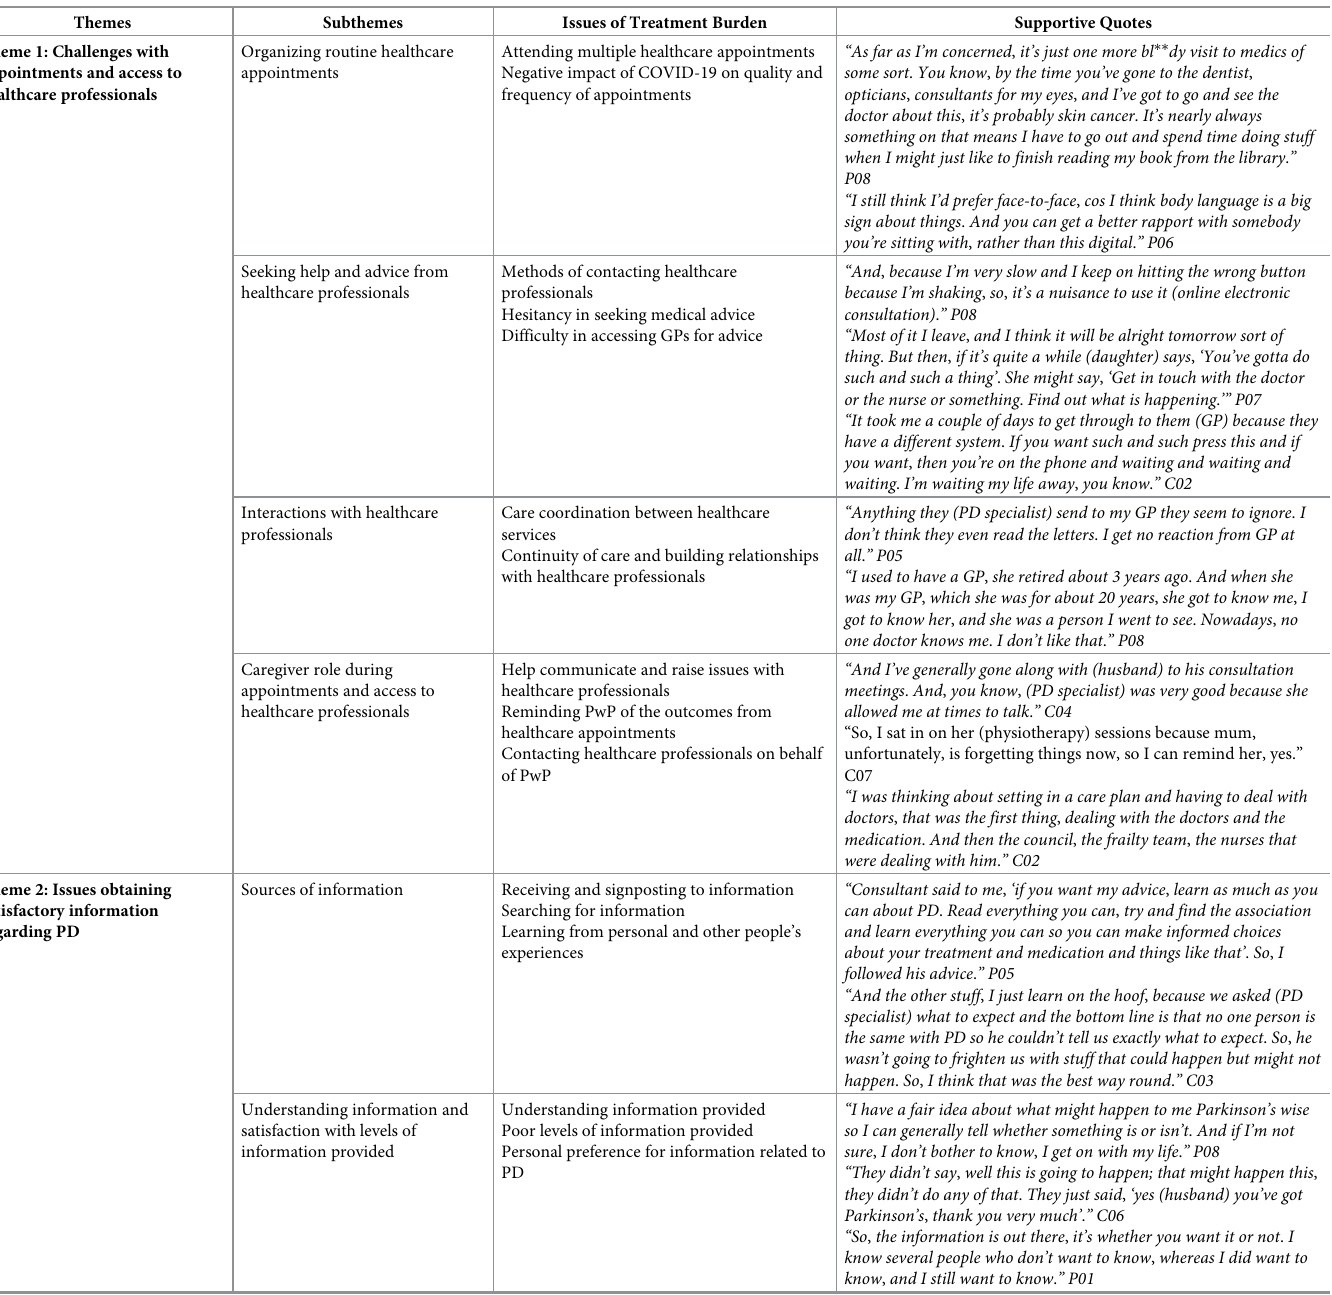
Table 2. Examples of participants’ quotes of treatment burden in Parkinson’s